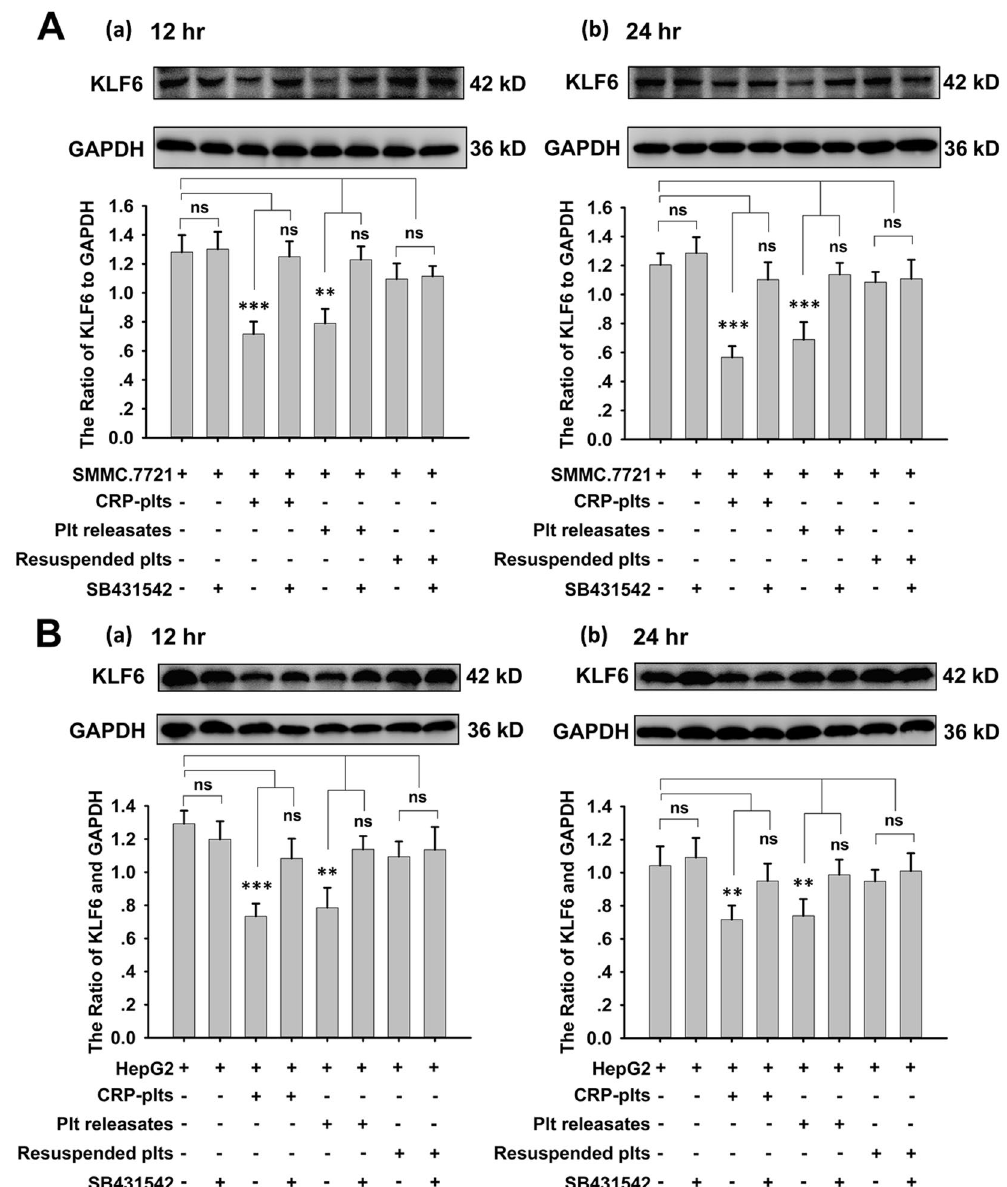
Figure 5. Platelet-derived TGF- β regulates the expression of KLF6 in HCC cells. SMMC.7721 ( A ) and HepG2 ( B ) cells were incubated with CRP-activated platelets, platelets releasates, and resuspended platelet pellets in the absence and presence of TGF- β receptor inhibitor SB431542 (10 μ M). KLF6 expression was detected by a Western blot analysis in HCC cells after 12 (a) or 24 (b) hours of treatment. Data were quantified and are shown as the mean ± SEM (n = 5, ** p < 0.01 compared with